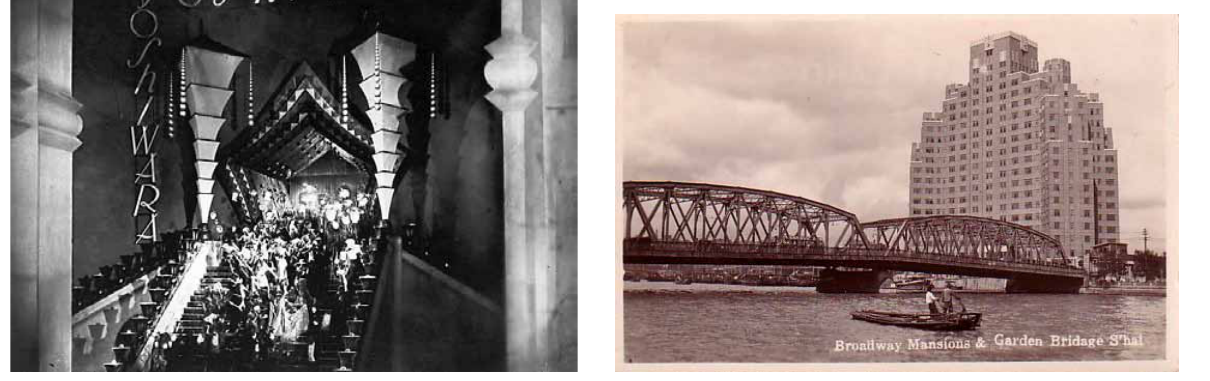
tavern songstress, always surrounded by her trumpe- ter boyfriend and his very protective beggar friends (the street angels of the title). Its opening title sets the scene: “Autumn 1935. In the world of Shanghai’s un- derclasses”. As the opening credits are still rolling, the movie shows us, through a combination of camera mo- vements, the cityscape of Shanghai as a shiny beacon of modernity, all neon lights, western style buildings, theatre marquees, cars, crowds, dancing halls, churches with their chiming bells. Then the camera focuses on the top of a tall, white, deco looking skyscraper, clearly an imaginary maquette , but recalling the Broadway Mansions 4 (see Fig. 6) or the Park Hotel Shanghai 5 (see Fig. 7). From there the camera slowly tilts downward to the ground floor and beneath, to the underground, or better, the underbelly of Shanghai, where the poor,